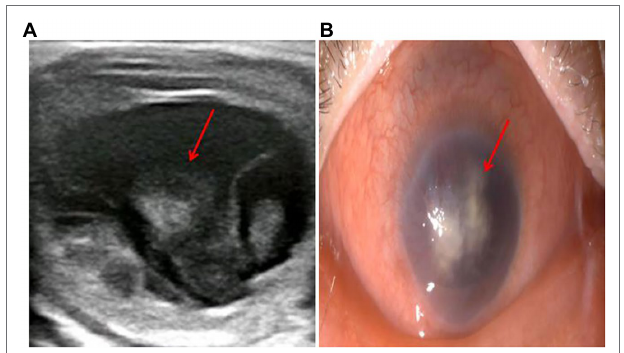
FIGURE 3 | The diagnosis of vitreous abscess 50 days after admission. (A) Repeat ocular ultrasonography; (B) anterior segment photograph; the patient’s right eye showed severe vitreous opacity, incomplete posterior vitreous detachment, exudative retinal detachment (with numerous diffuse and weak echoes from the bulbar wall), bulbar wall thickening, and bulbar sac